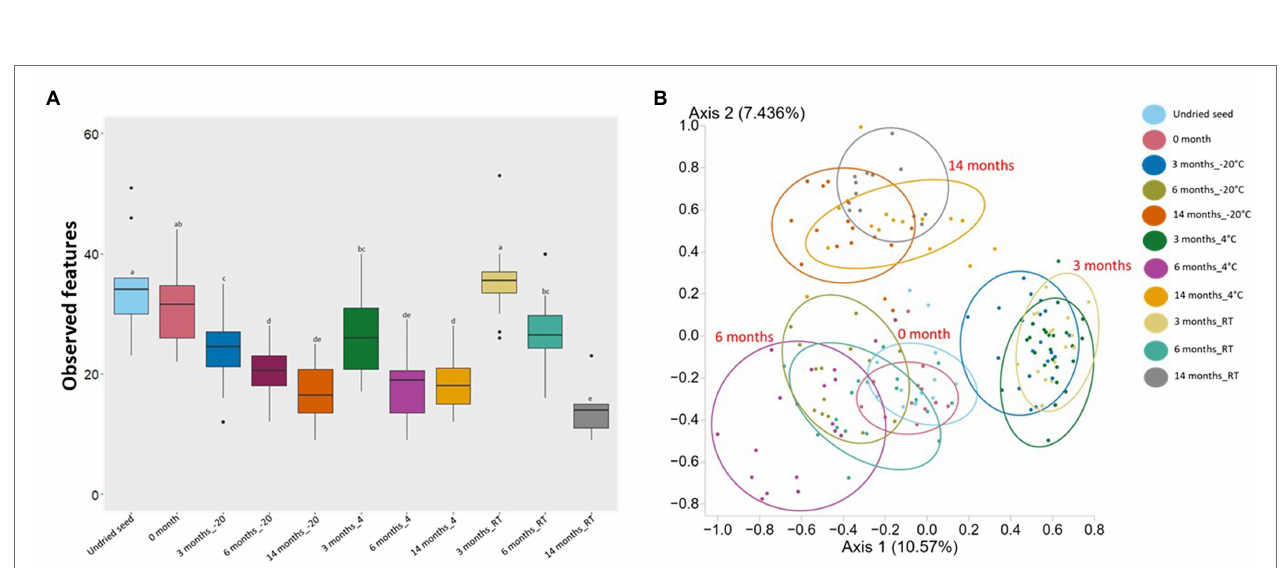
FIGURE 2 | Alpha diversity (Observed features) and Beta diversity analysis (Jaccard dissimilarity) of the G. max seed ( in planta ). (A) Box-and-whisker plots showing the number of features observed under all conditions. Significant differences ( p ≤ 0.05) were assessed by ANOSIM pairwise test and are indicated by different lowercase letters ( Supplementary Table S3 ). (B) Principal Coordinates Analysis (PCoA) plot showing the distances in the bacterial communities between undried seed and dried seed (0, 3, 6, and 14 months) stored at − 20 ° C (±2 ° C), 4 ° C (±2 ° C), and room temperature (RT; 22 ± 2 ° C). Significant differences in bacterial composition were tested using the ANOSIM pairwise test ( Supplementary Table S3